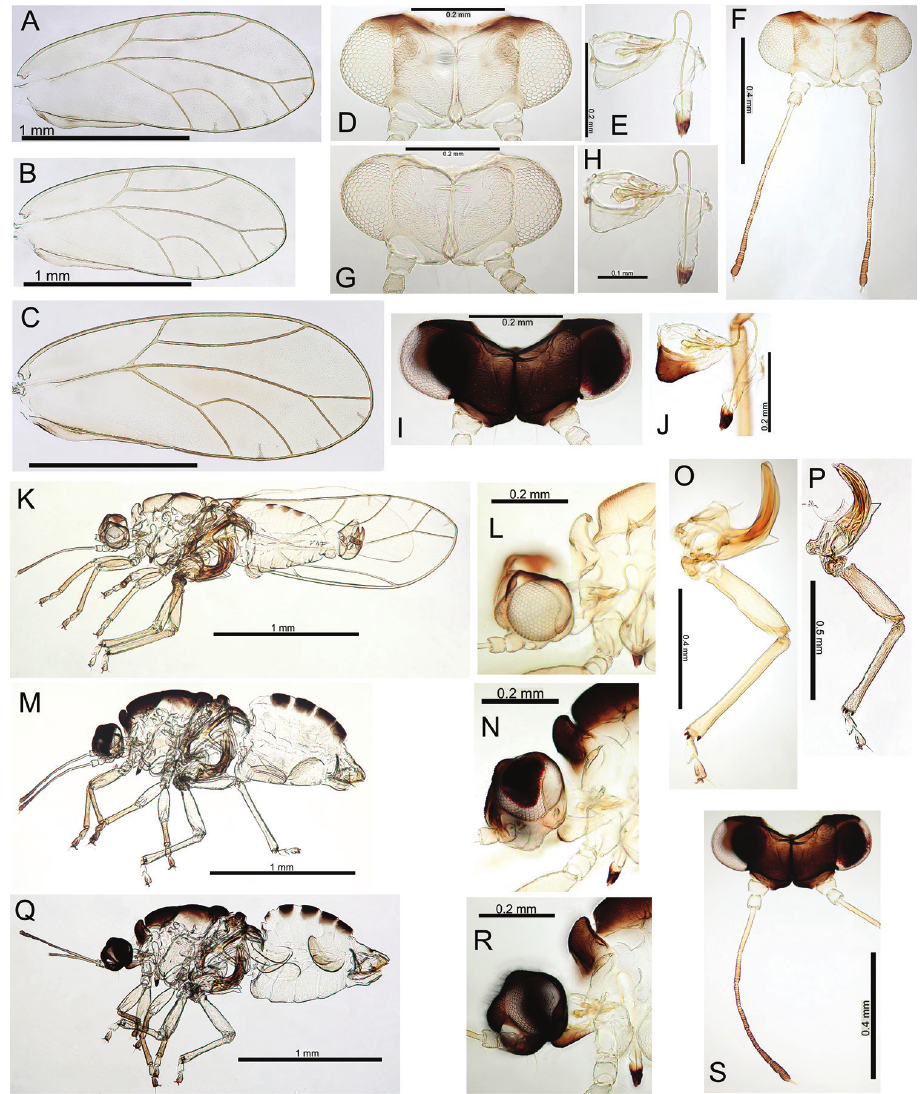
Figure 6. Pariaconus hina sp. n. A, B, C fore wing: A form ovostriatus B form occidentalis C form orientalis (female) D, E, F head, proboscis, head and antennae, form ovostriatus G, H head, proboscis, form occidentalis I, J head, proboscis, form orientalis (female) K, L male, form ovostriatus O hind leg, form ovostriatus P hind leg, form occidentalis M, N female, form ovostriatus Q, R, S female, head and antenna (female), form orientalis